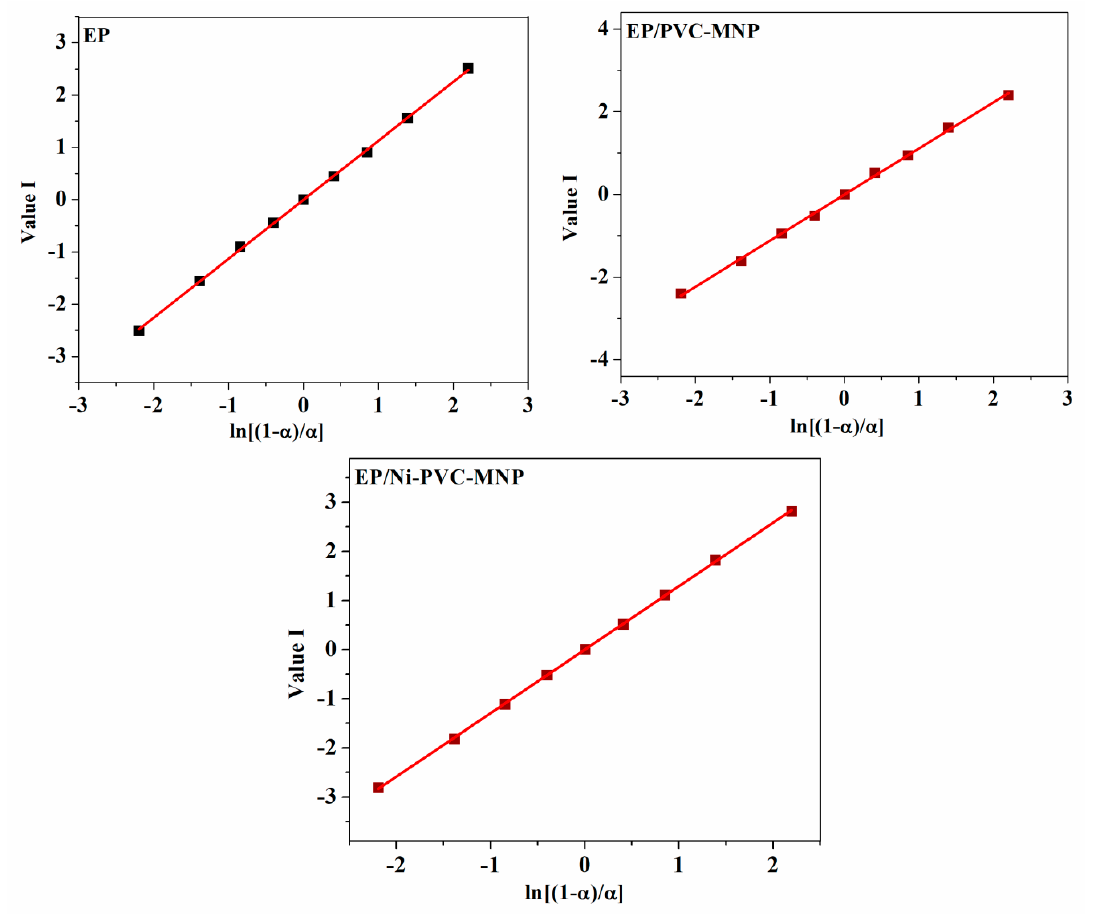
Figure A4. Value I of the samples at 5 °C/min.